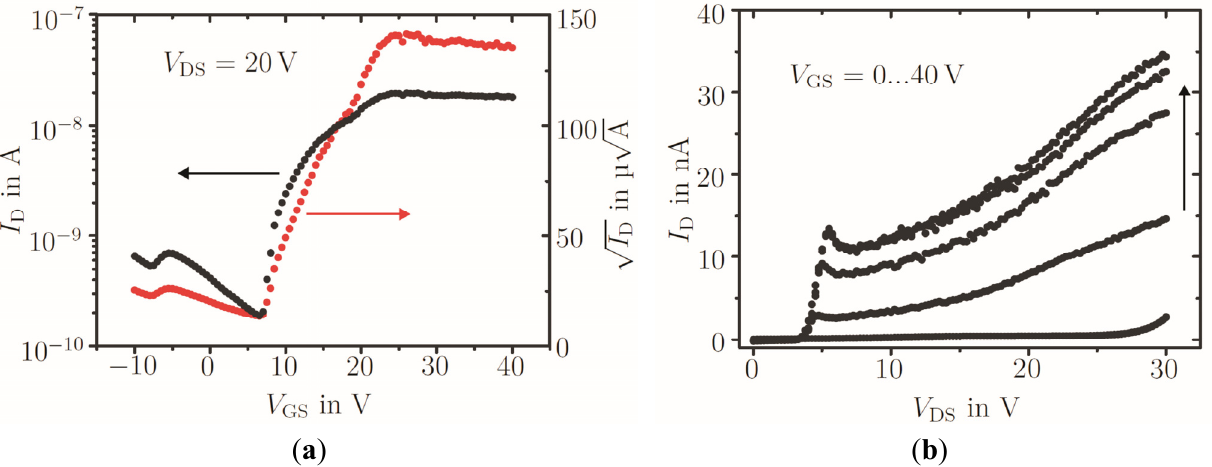
Figure 14. ( a ) Transfer and ( b ) output characteristics of an inverted coplanar ZnO nanoparticle TFT (L = 8 µm, W = 16000 µm and t ox = 300 nm). © 2015 IEEE. Reprinted, with permission, from [3].